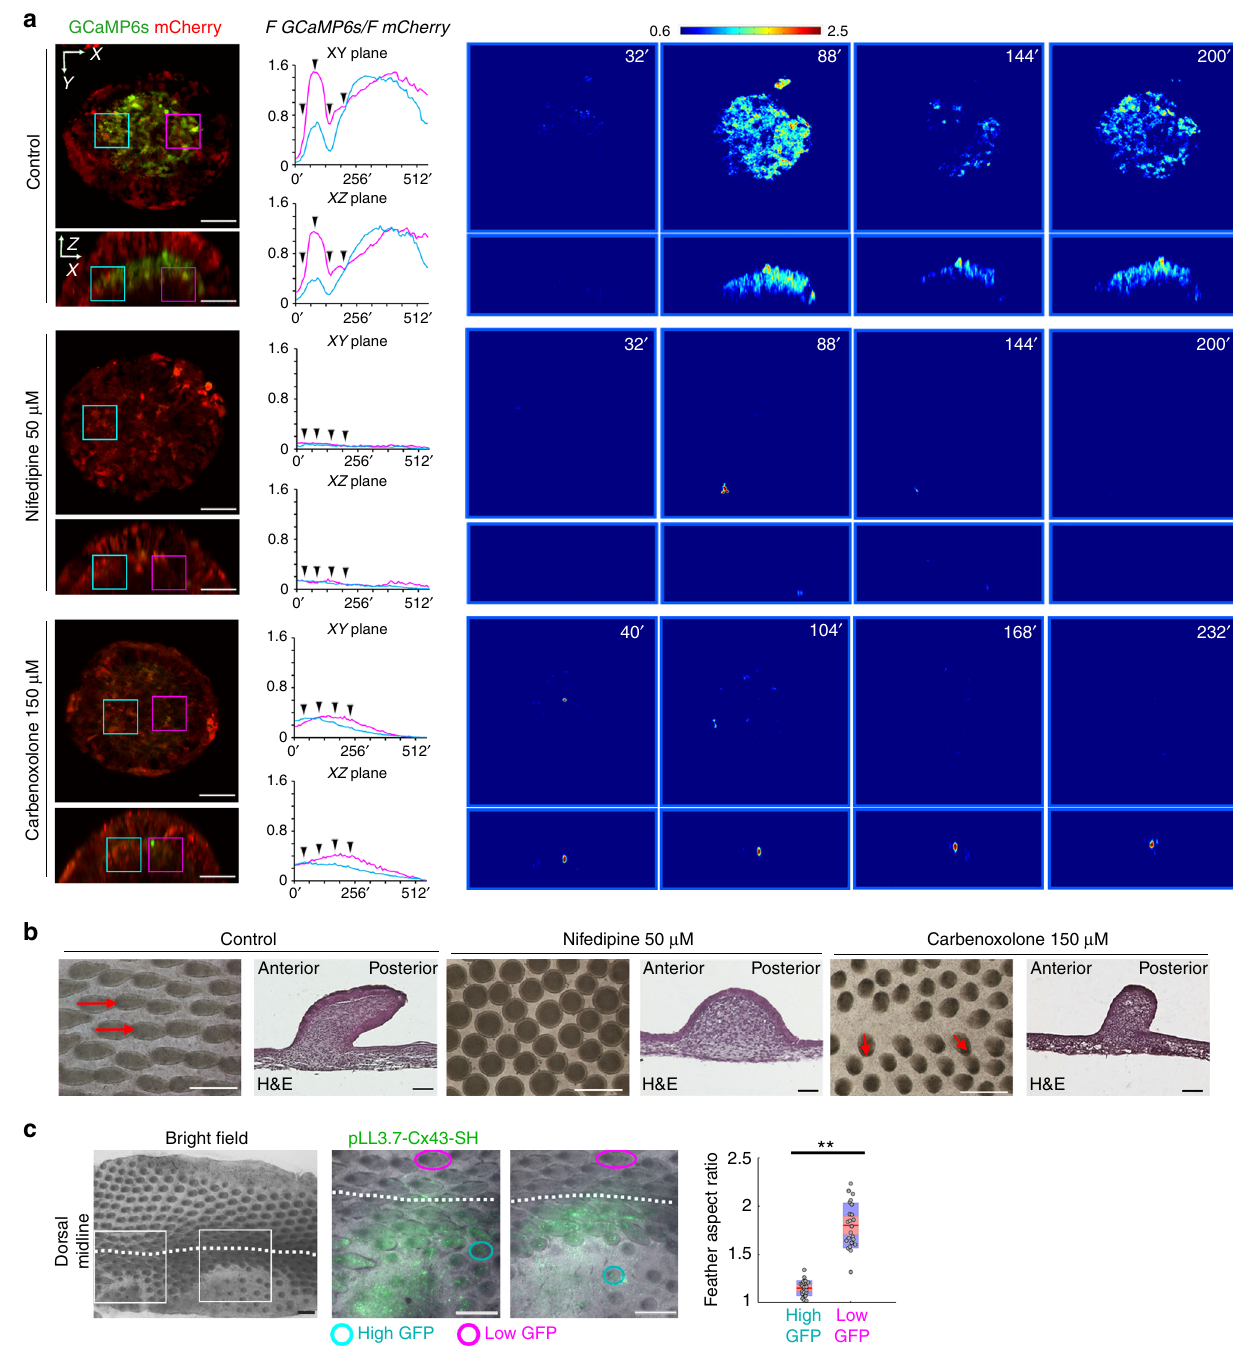
Fig. 5 Modulating physiological Ca 2 + oscillations alters feather elongation process. a Virtual sections of 4D ratiometric Ca 2 + imaging of elongating feather buds on H&H 34 skins ( n = 3). ROI analysis of GCaMP6s and mCherry fl uorescence ratio exhibited synchronized Ca 2 + oscillations in anterior (cyan rectangle) and posterior (magenta rectangle) mesenchyme. The high Ca 2 + area expanded anteriorly over time (the intersection of cyan and magenta lines). ′ in x -axis denotes minutes. Pseudocolor ratiometric images were shown at selected times (arrowheads). 50 μ M Nifedipine or 150 μ M Carbenoxolone treatment dramatically reduced the number of cells showing elevated Ca 2 + ( n = 2). Scale bar, 50 μ m. b Feather buds on H&H 31 skins became elongated fi laments oriented posteriorly after 4-day culture with DMSO (red arrows, n = 10/10). Nifedipine-treated feather buds were shorter and had no apparent anterior – posterior polarity ( n = 8/8). 150 μ M Carbenoxolone treatment inhibited feather elongation and disrupted feather polarities (red arrows, n = 6/6). H&E: Hematoxylin and Eosin staining. Scale bars, 500 μ m (whole-mount skin), 50 μ m (section). c In H&H 35 Skins, the regions ( n = 4/4) infected with lentivirus encoding Connexin-43 shRNA (pLL3.7-Cx43-SH) exhibited dramatically inhibited elongation of young feather buds (cyan ellipses) compared to the control side (magenta ellipses, n = 23 for each group, ** P < 0.01, Wilcoxon rank test). Rectangles highlight magni fi ed area. Scale bar, 500 µ m. Customized boxplot: Mean (red) ± s.d. (pink), 95% con fi dence interval (violet). Dots denote individual data